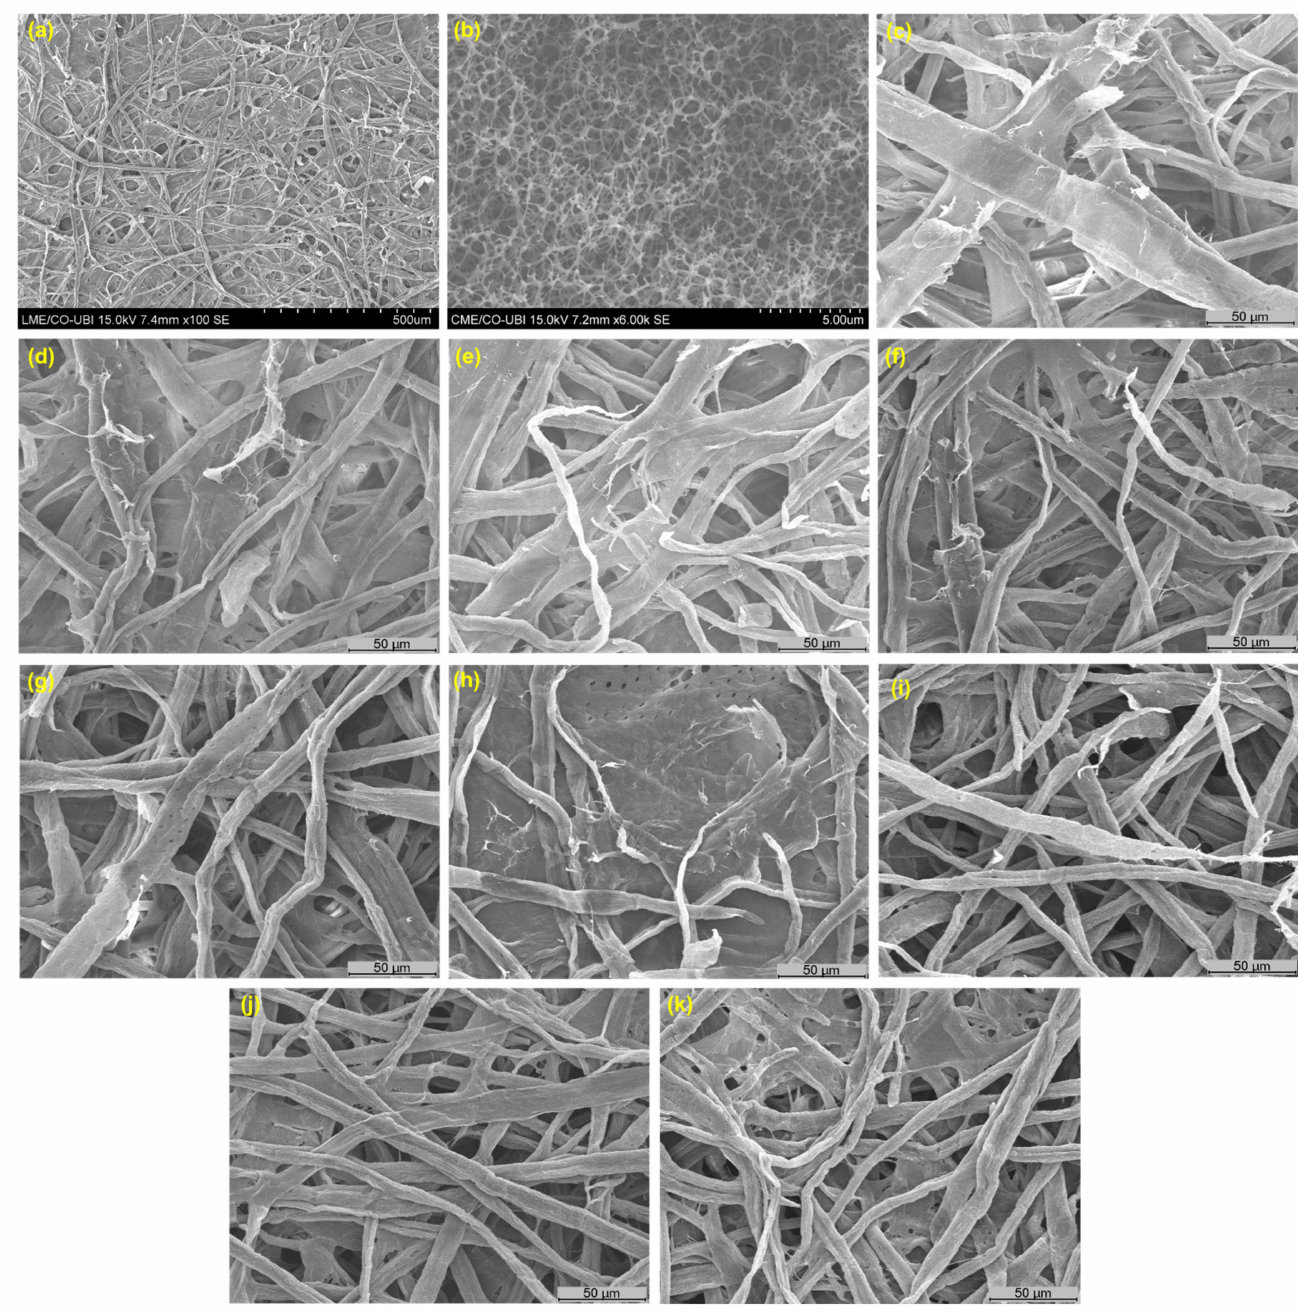
Figure 3. SEM image of morphology and 3D network of MFC ( a ), CMC ( b ) [33], F1 ( c ), F2 ( d ), F3 ( e ), F4 ( f ), F5 ( g ), F6 ( h ), F7 ( i ), F8 ( j ), and F9 ( k )